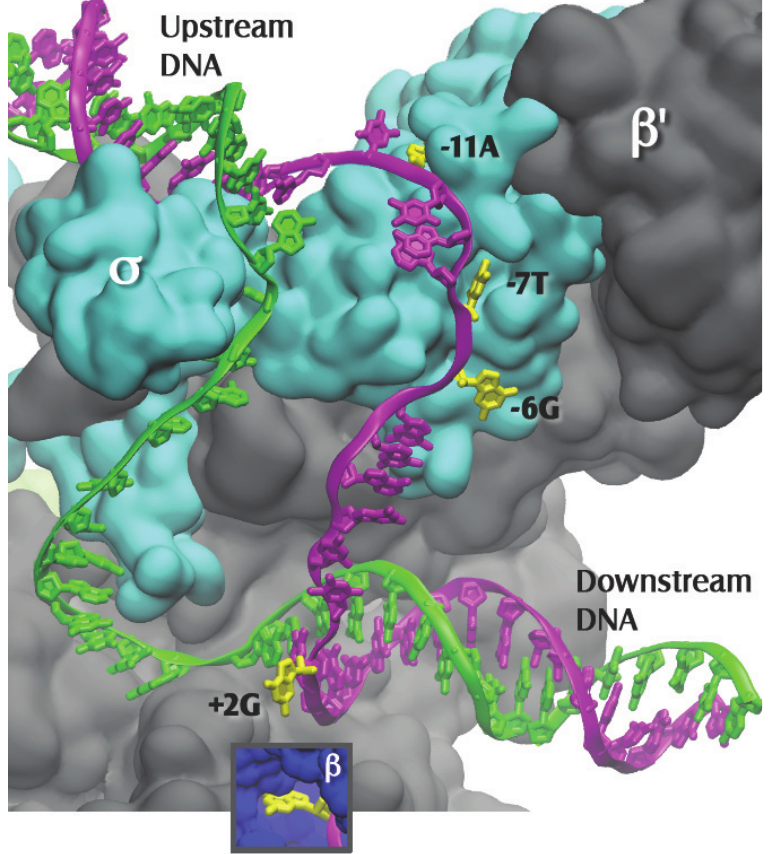
Figure 2. Close up of Figure 1, with the (cid:5) subunit removed to reveal the transcription bubble and the flipped bases in their pockets. Template DNA is in green and nontemplate DNA is in magenta, with the flipped-out bases in yellow. Bases (cid:3)11A and (cid:3)7T interact solely with the (cid:2) subunit. Base (cid:3)6G is at the (cid:2)-(cid:5) subunit interface. Base +2G interacts solely with the (cid:5) subunit (insert). The (cid:3)12T nontemplate base is shown in the figure as unpaired, as it is in